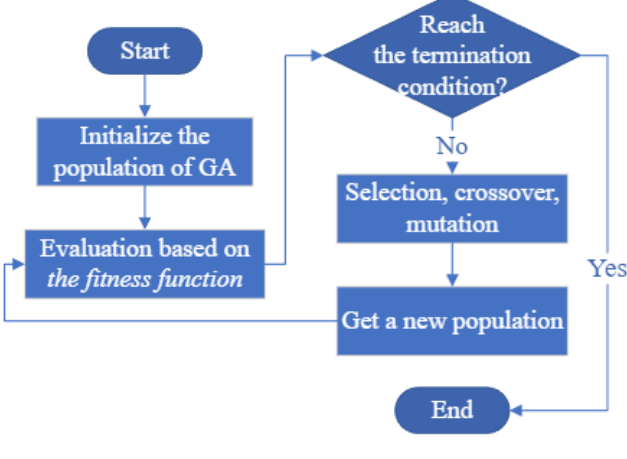
Figure 7. Flowchart of the GA algorithm.